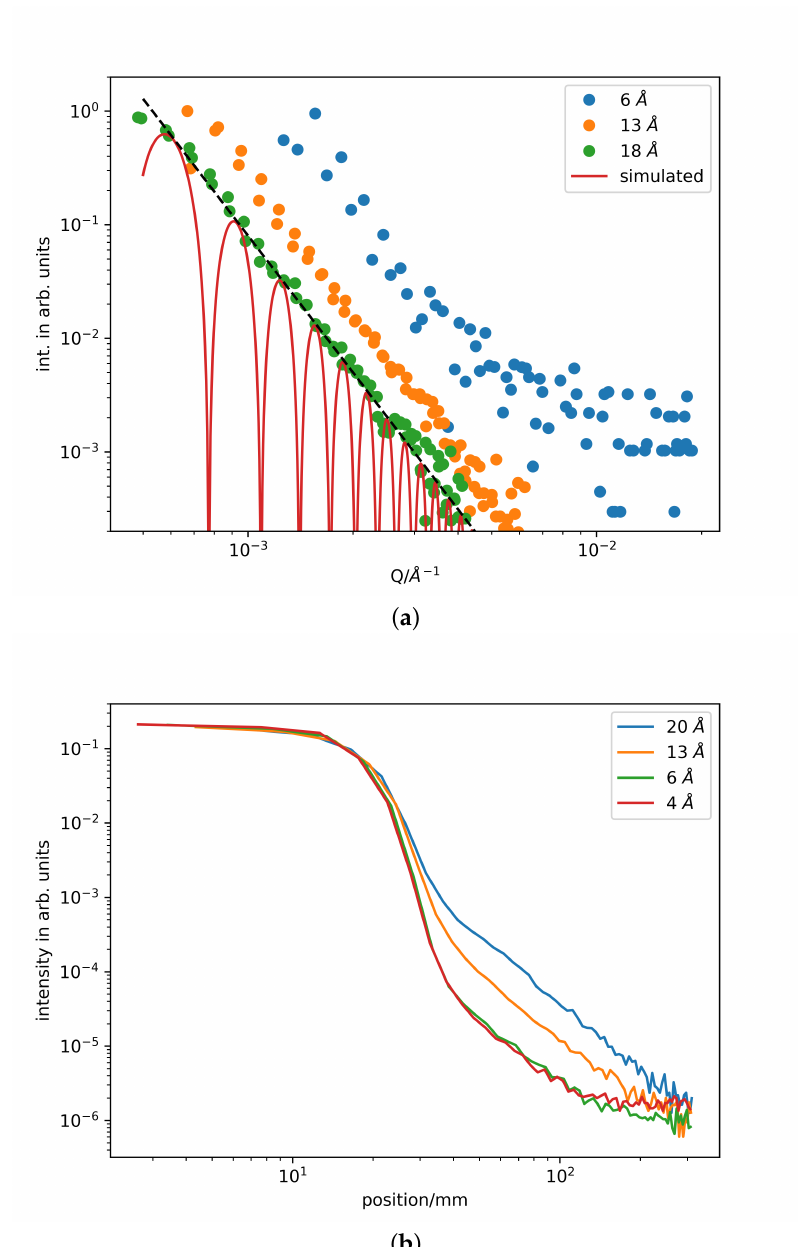
Figure 6. ( a ) Scattered intensity of 1 µ m latex particles in D 2 O for several wavelengths ( • ) and from simulation (solid line); ( b ) beam profile on detector for the indicated wavelengths. Both datasets were recorded on the PA20 instrument at LLB, CEA Saclay. When comparing the simulated and recorded scattering of the latex particles, it becomes clear that the minima of such particles could not be resolved by the given instrument resolution. This results from the pixel size of the detector being 5 mm × 5 mm and the beam spot size of about 30 mm in the closest direction. However, the slope of the maxima is reproduced well (dashed line reproduces I ∝ Q − 4 behavior). The difference in inten- sities is due to the spectrum available at the instrument. When considering the beam spot size, it be- comes apparent that, at higher wavelength, the Gd of the coating starts to contribute more strongly to be scattering. This leaves an optimization process of the smallest usable Q-values to hot commissioning. Probably strongly scattering samples can achieve a lower Q-value, since the additional contribution due to the radial collimator is